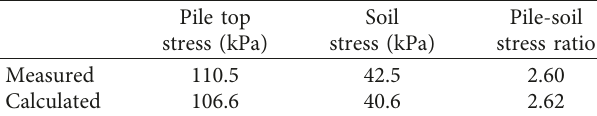
Table 2: Comparison between calculated and measured stress.